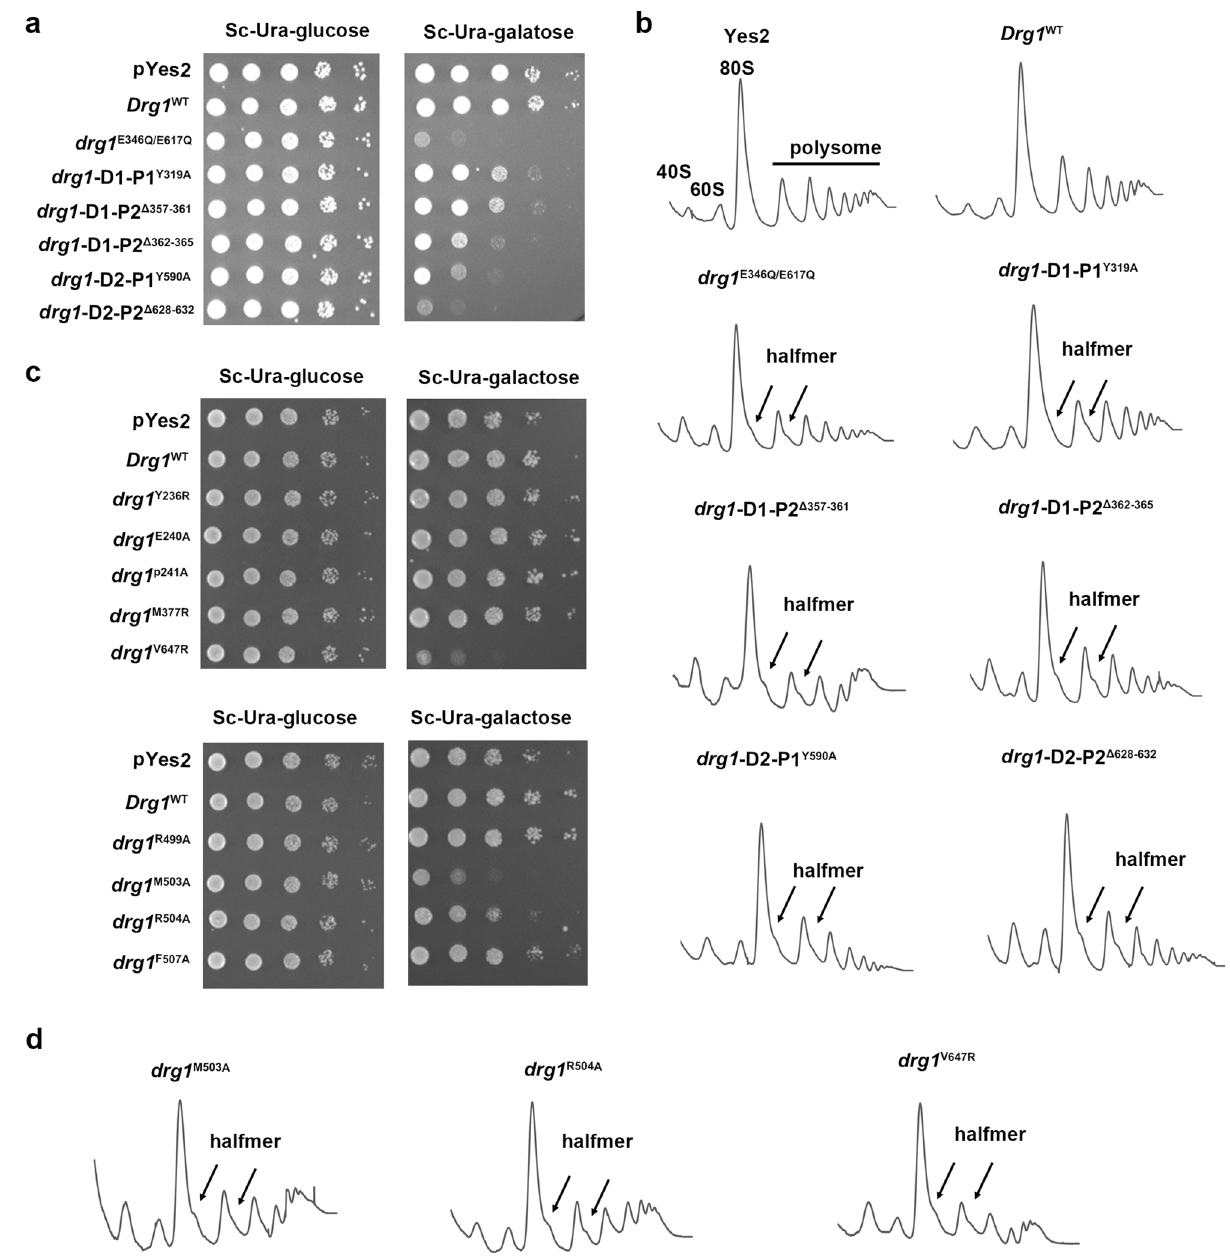
Fig. 6 | Critical residues of the PLs, the D1-D2 linker and the ISS motifs are important for the in vivo function of Drg1. a Drg1 pore-loop mutants suppress cell growth. Yeast BY4741 cells carrying different Drg1 variants (E346A/E617A, Y319A, Δ 357-361, Δ 362-365, Y590A, Δ 628-632) were grown to mid-log phase in liquid medium, diluted, and spotted on SC-Ura medium with 2% glucose or galac- tose and incubated at 30°C. b Drg1 loop mutants impairs ribosome assembly and lead to a “ halfmer ” phenotype. Yeast BY4741 cells expressing different variants were lyzed and the lysates were subjected to a sucrose gradient-based polysome pro fi lesanalysis. The position of 40S,60S,80S,and polysomepeaksare indicated.